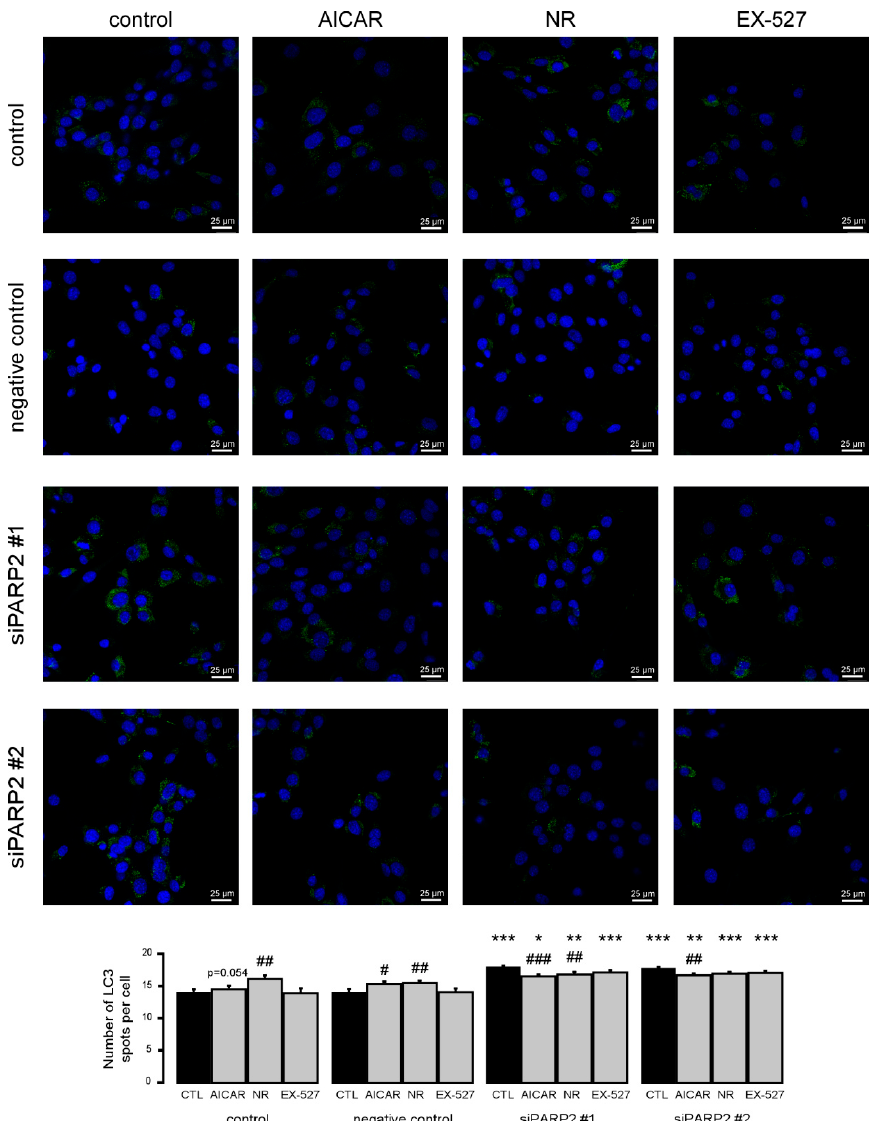
Figure 8. Increased autophagy upon acute PARP2 silencing. PARP2 was transiently silenced in C2C12 cells using siRNA targeting PARP2 ( n = 3). Cells were transfected with siRNA for 48 h, treated with 1 mM AICAR, 500 µM nicotinamide-riboside (NR), and 25 µM EX-527 for 24 h, then LC3 expression was assessed by confocal microscopy. Alexa Fluor 488-linked LC3 specific antibody was used and the nuclei were visualized using DAPI and vesicles were counted. #, ## and ### represent statistically significant differences between the control and treated cells at p < 0.05, p < 0.01 or p < 0.001, respectively. *, **, and *** represent statistically significant differences between the scPARP2 and shPARP2 cells at p < 0.05, p < 0.01, and p < 0.001, respectively. For the determination of statistical significance, ANOVA test was used followed by Tukey’s post hoc test.